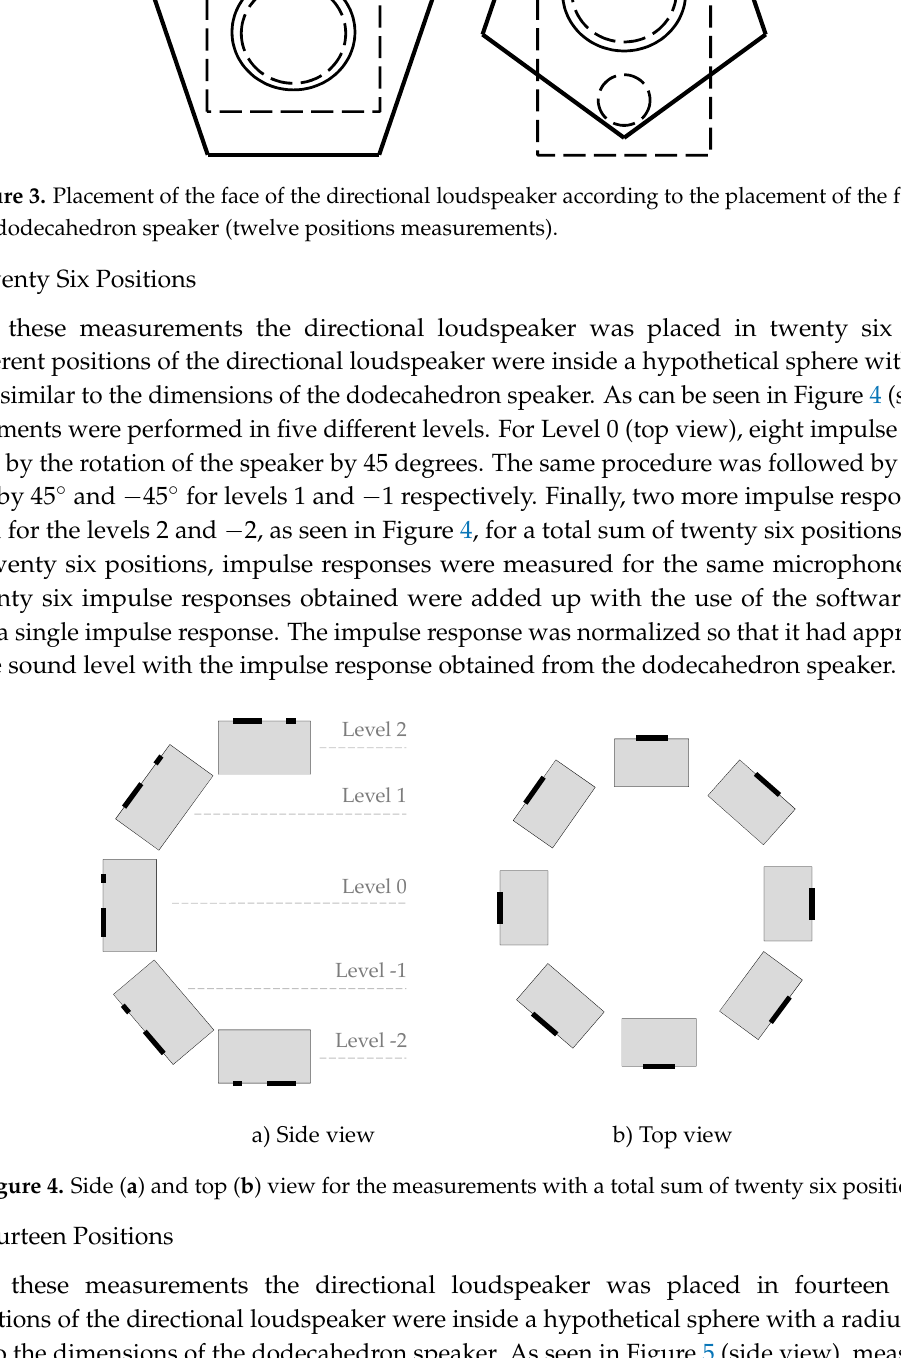
Figure 4. Side ( a ) and top ( b ) view for the measurements with a total sum of twenty six positions.